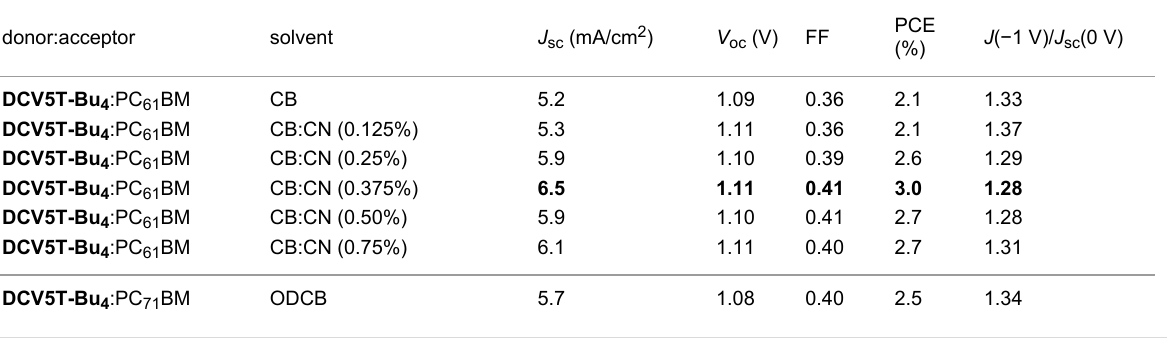
Table 2: Photovoltaic parameters of solar cells fabricated using DCV5T-Bu 4 :PCBM from chlorobenzene, chloronaphthalene as additive, and spin- coated at 80 °C. Device structure: ITO|PEDOT:PSS| DCV5T-Bu 4 :PCBM (1:1)|LiF|Al.